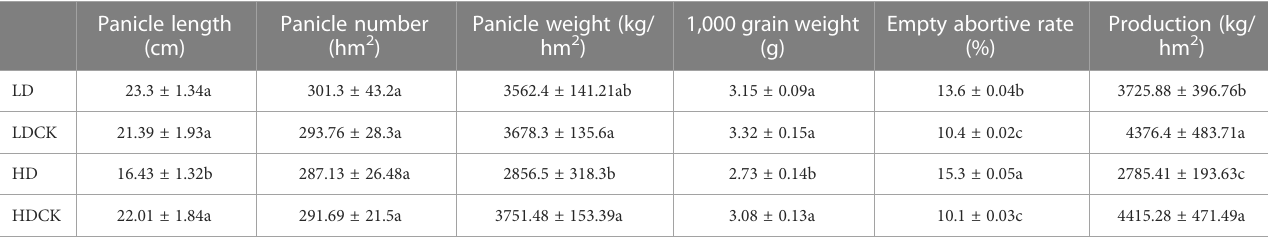
Different lowercase letters show signi fi cant difference at the P =0.05 level in the same column.